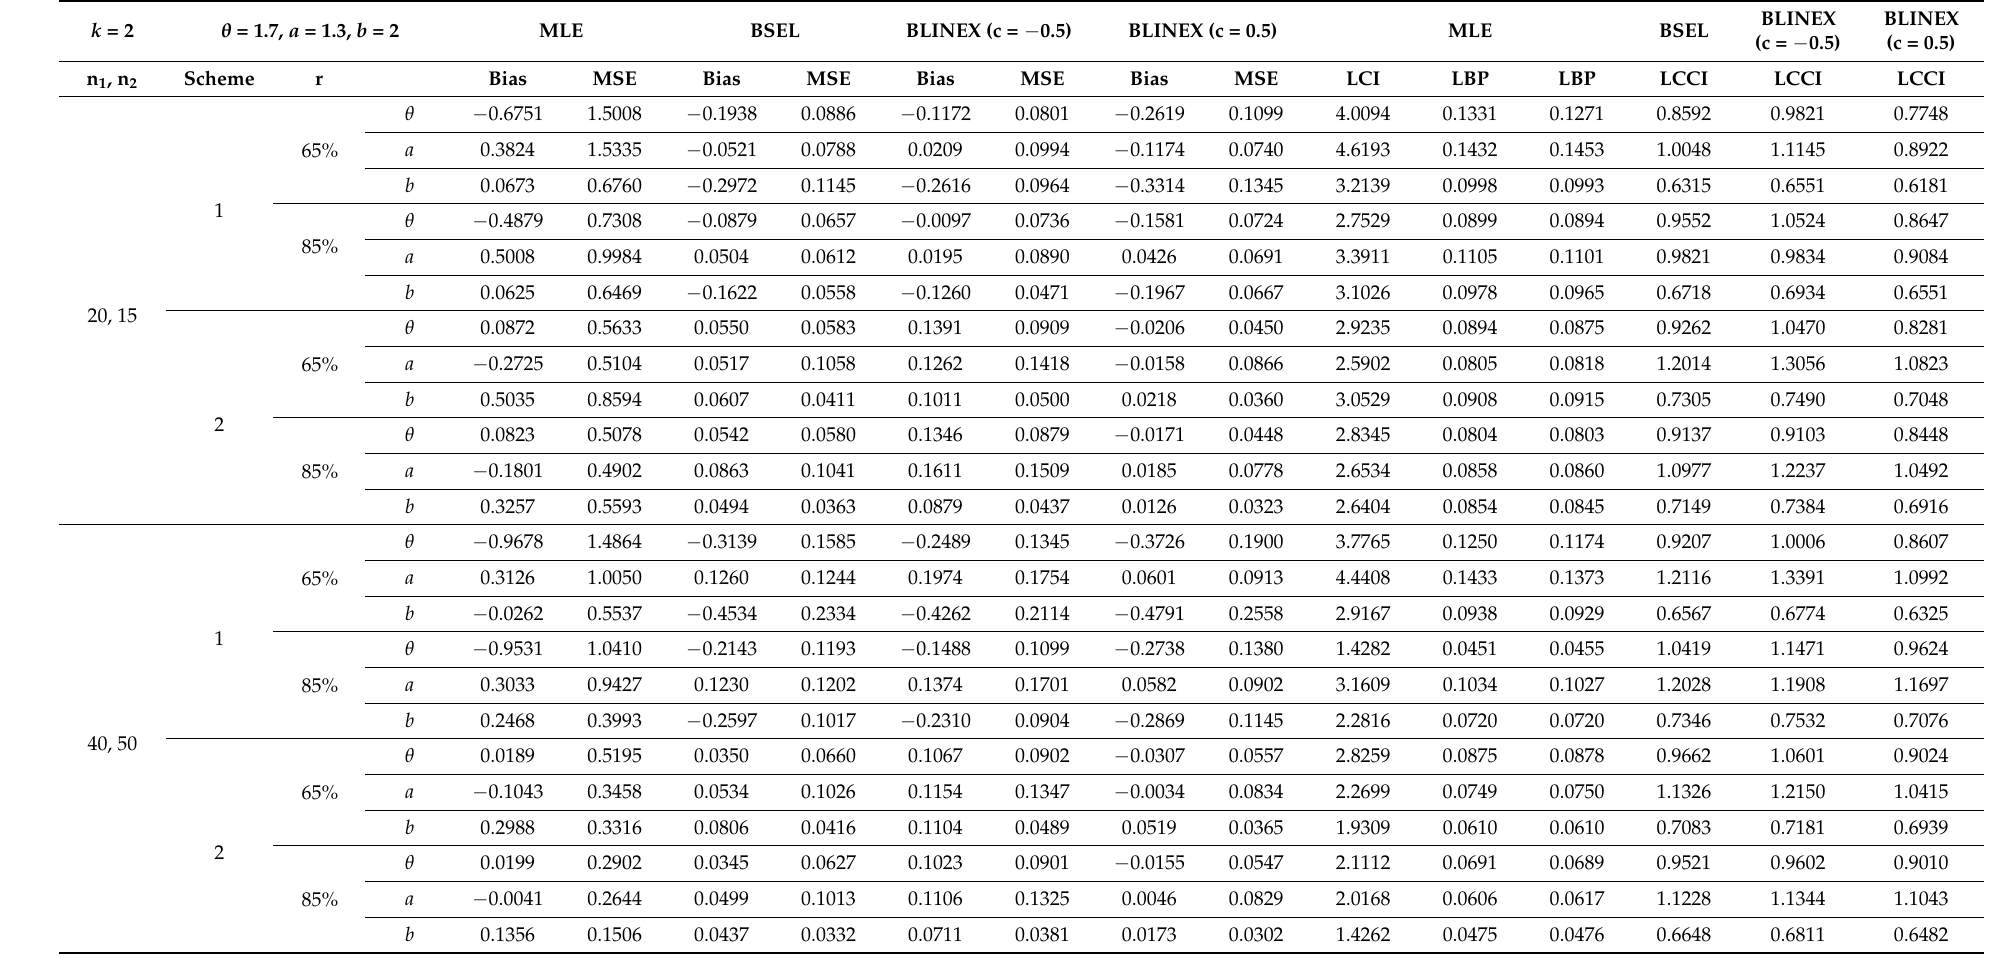
Table 1. MLE and Bayesian estimation with different loss functions in the simple ramp when θ = 1.7, a = 1.3, b =